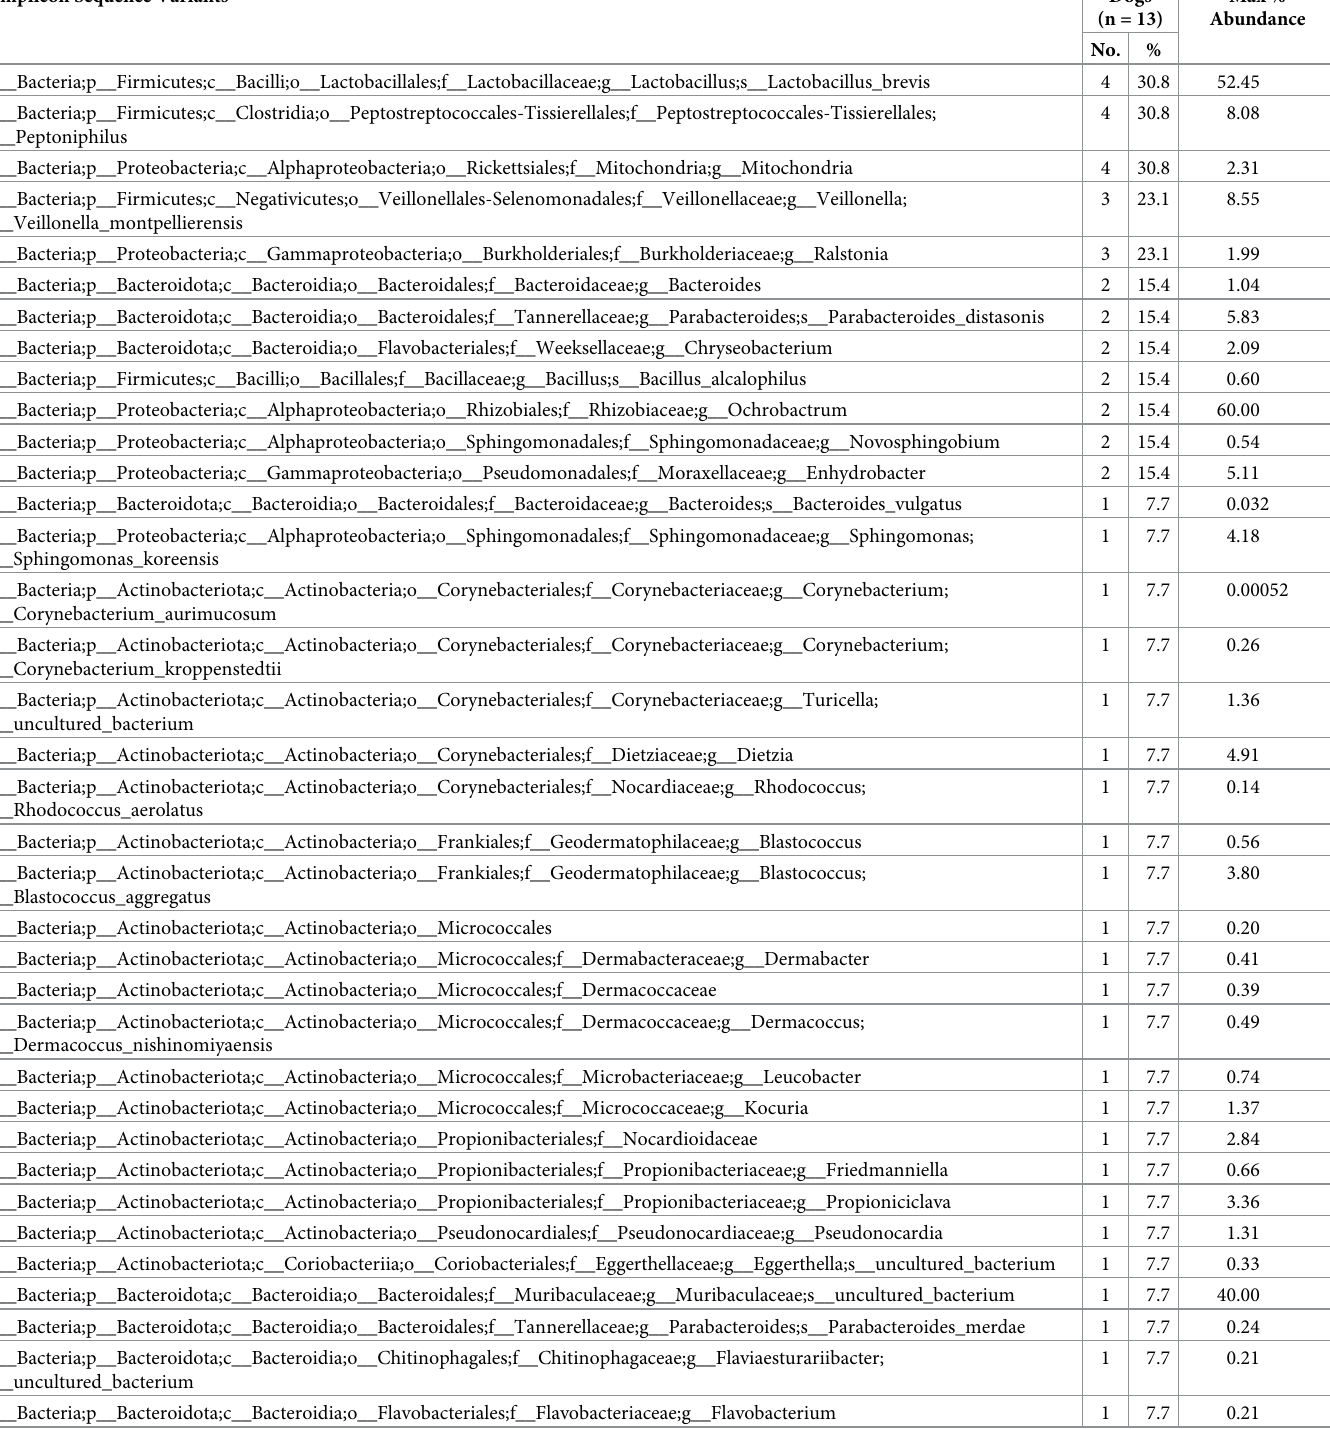
Table 2. Seventy eight amplicon sequence variants amplified from gallbladder mucus collected from 13 dogs with mucocele formation and not observed in extrac- tion control samples that did not contain mucus. Amplicon Sequence